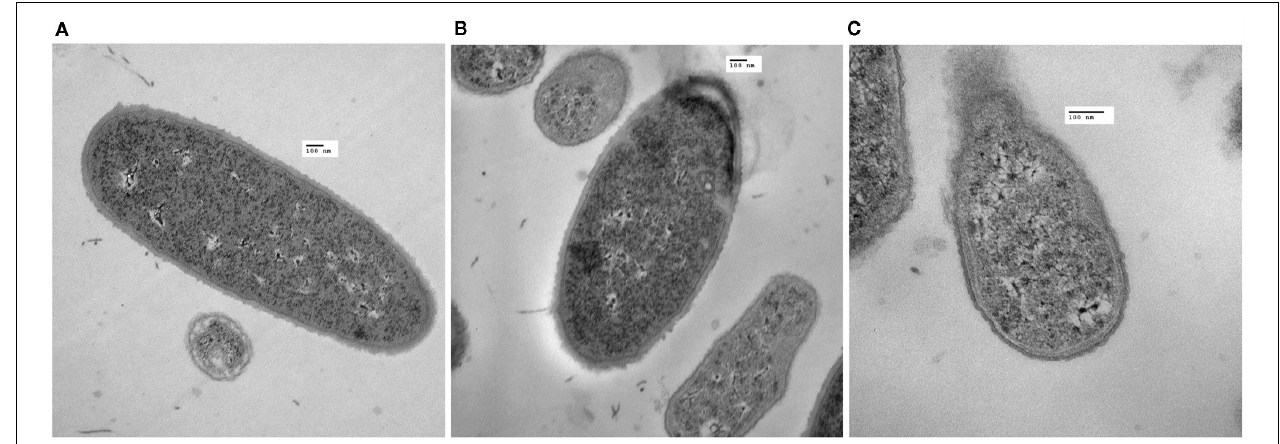
FIGURE 6 | Electron microscopy of RB51 and RB51SOD outer membrane damage. RB51 lacked outer membrane damage (A) . Outer membrane damage appeared on the surface of RB51SOD (B,C) .The scale bar represents a length of 100nm.